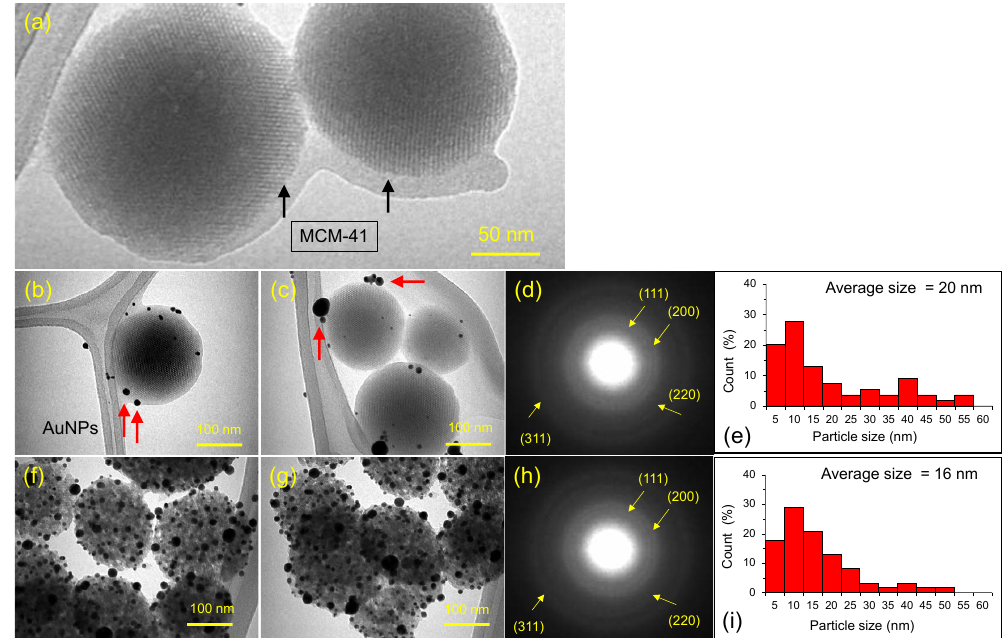
Figure 3. TEM images, SAED patterns, and size histogram of PLAL-prepared Au–MCM-41–CTAB composite; ( a ) pure MCM-41, ( b – e ) Au–MCM-41–full CTAB, and ( f – i ) Au–MCM-41–50% CTAB.